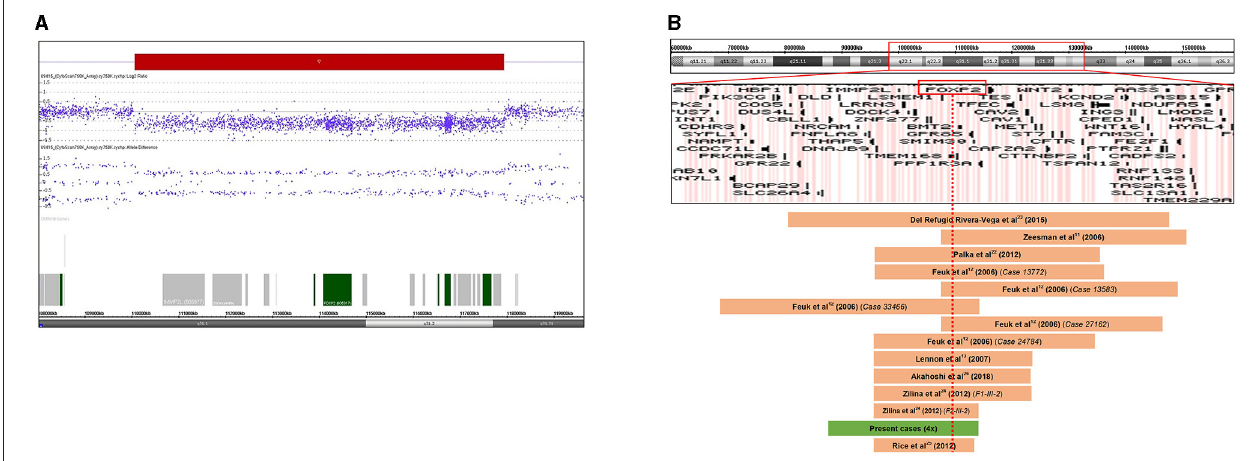
FIGURE 2 | (A) Result of chromosome microarray analysis. A 7.87Mb deletion at chromosome 7q31.1q31.31 (109708675-117578862). Signal intensity is plotted on a log2 scale, the deleted segment is shown as a red bar. Allele differences confirm the deletion. (B) Schematic representation of the 7q22q32 chromosomal region with gene content based on the UCSC Genome Browser. Deleted regions reported in previous cases are represented as brown bars, and the deletion of our patients is depicted as a green bar. FOXP2 gene is highlighted by a red rectangle. The red dotted line shows that all reported deleted cases involve the FOXP2 gene. Genomic positions refer to